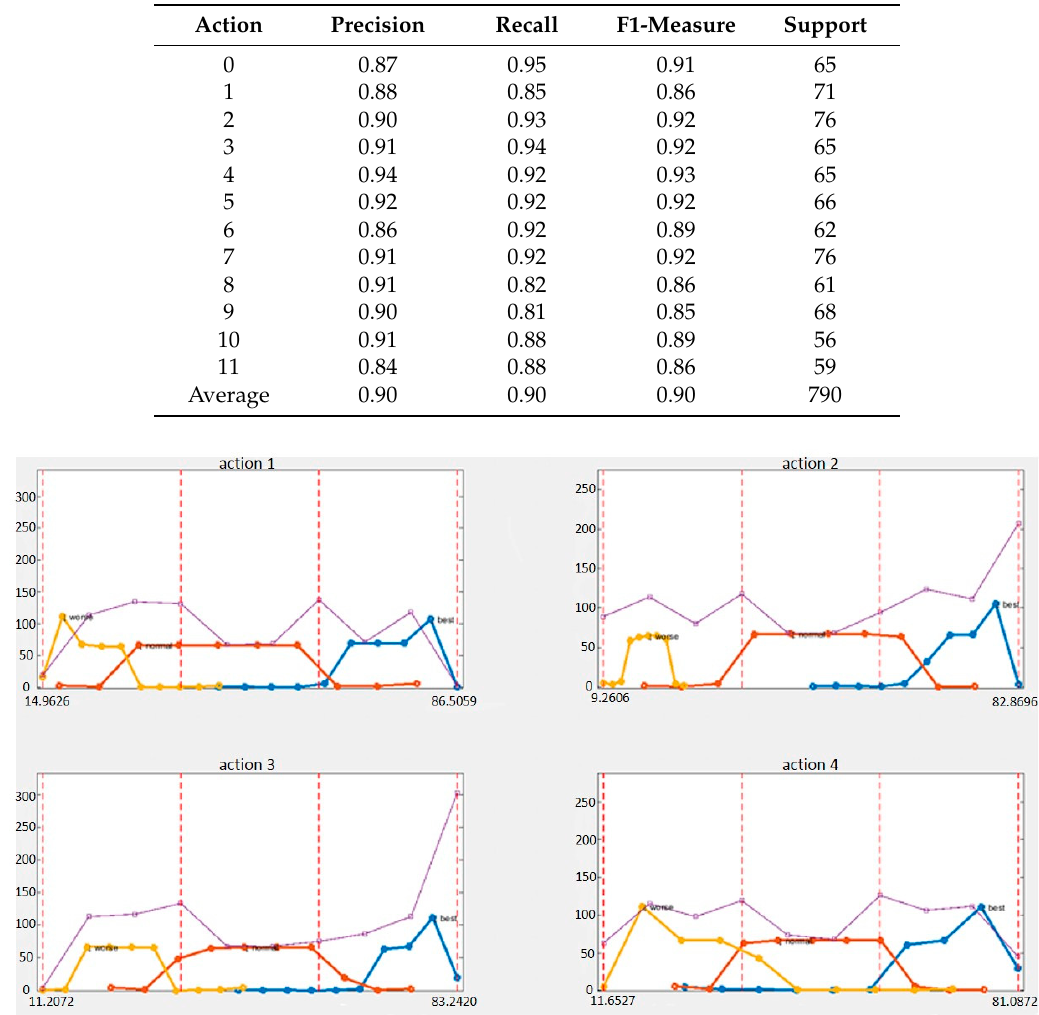
Table 8. Accuracy of precision, recall, and F1-Measure.